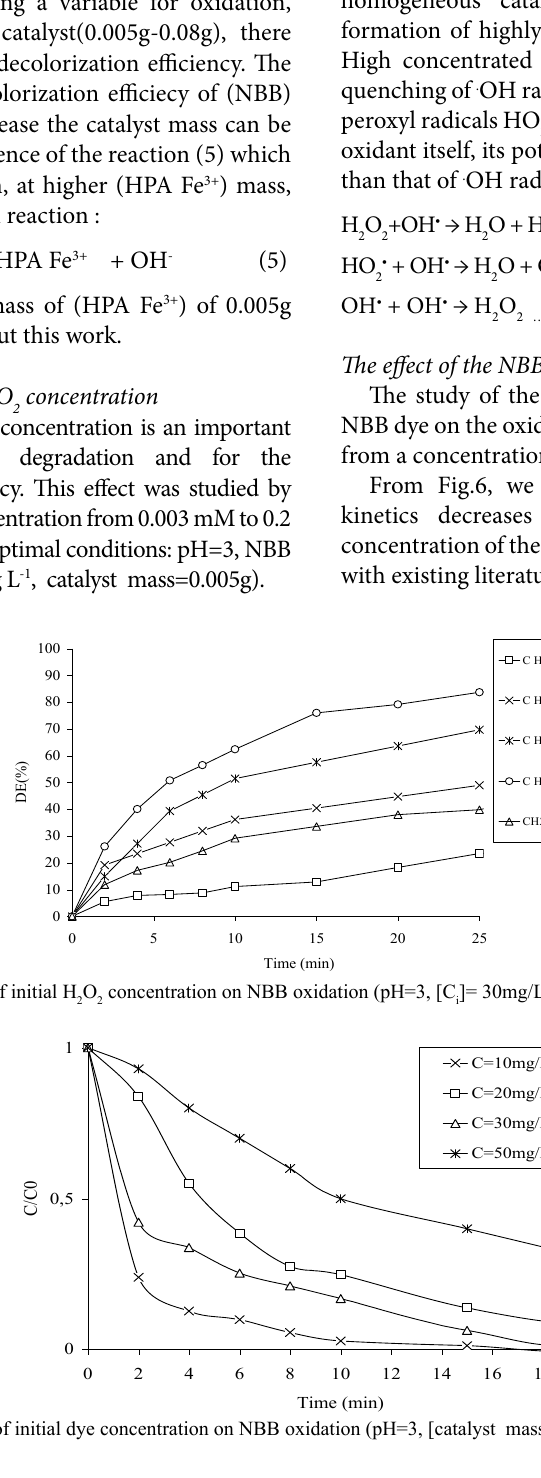
Figure 6: Effect of initial dye concentration on NBB oxidation (pH=3, [catalyst mass=0.005g, [H 2 O 2